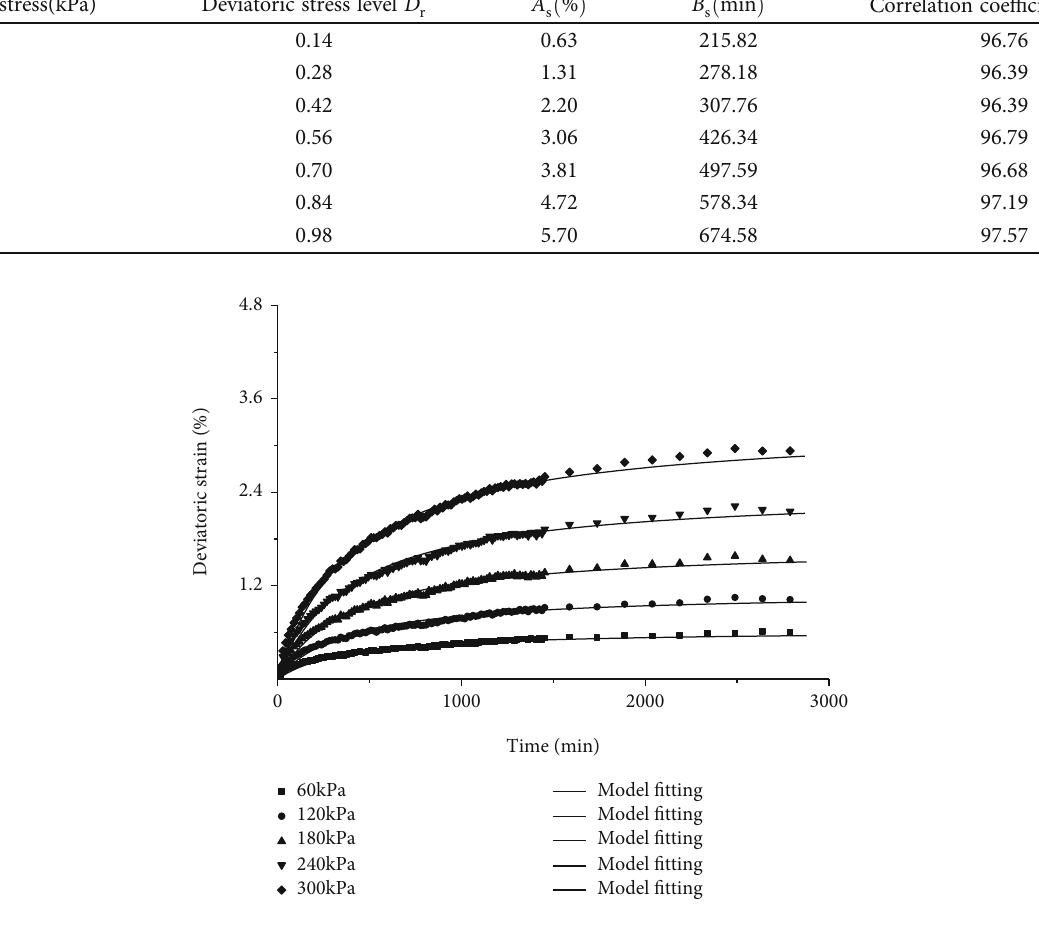
Figure 13: Fitting curves of total stress creep curve of reconstituted soil. Table 6: Hyperbolic model parameters and correlation coe ffi cient R 2 of triaxial creep test (reconstituted clay). Deviatoric